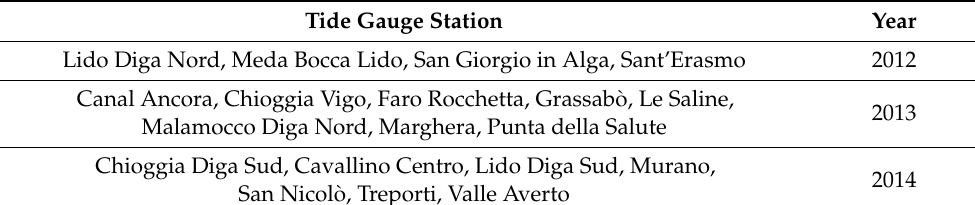
Table 1. Year considered for the tide prediction for each tide gauge station. Tide Gauge